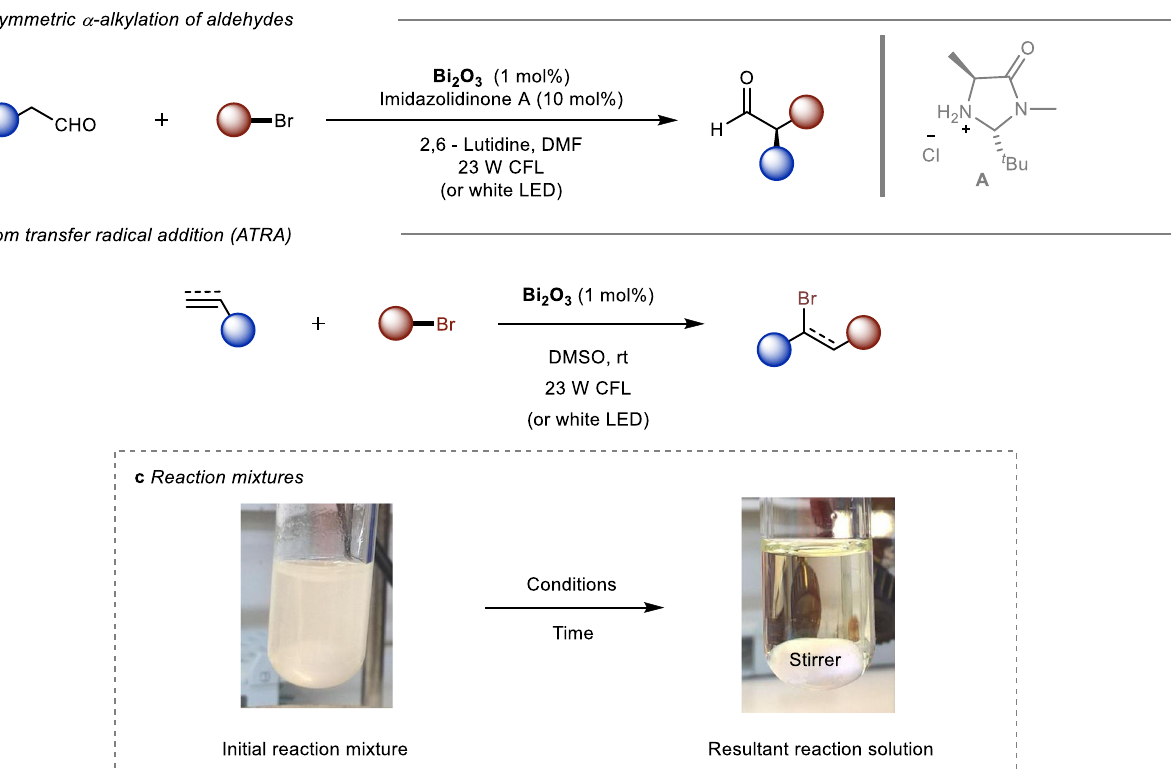
Fig. 1 Unusual behavior of the Bi 2 O 3 in photocatalysis. a α -Alkylation of aldehydes photocatalyzed by Bi 2 O 3 . b Atom transfer radical addition (ATRA) reaction photocatalyzed by Bi 2 O 3 . c Representative pictures of the reaction mixtures for both reactions. CFL compact luminescent lamp, LED light- emitting